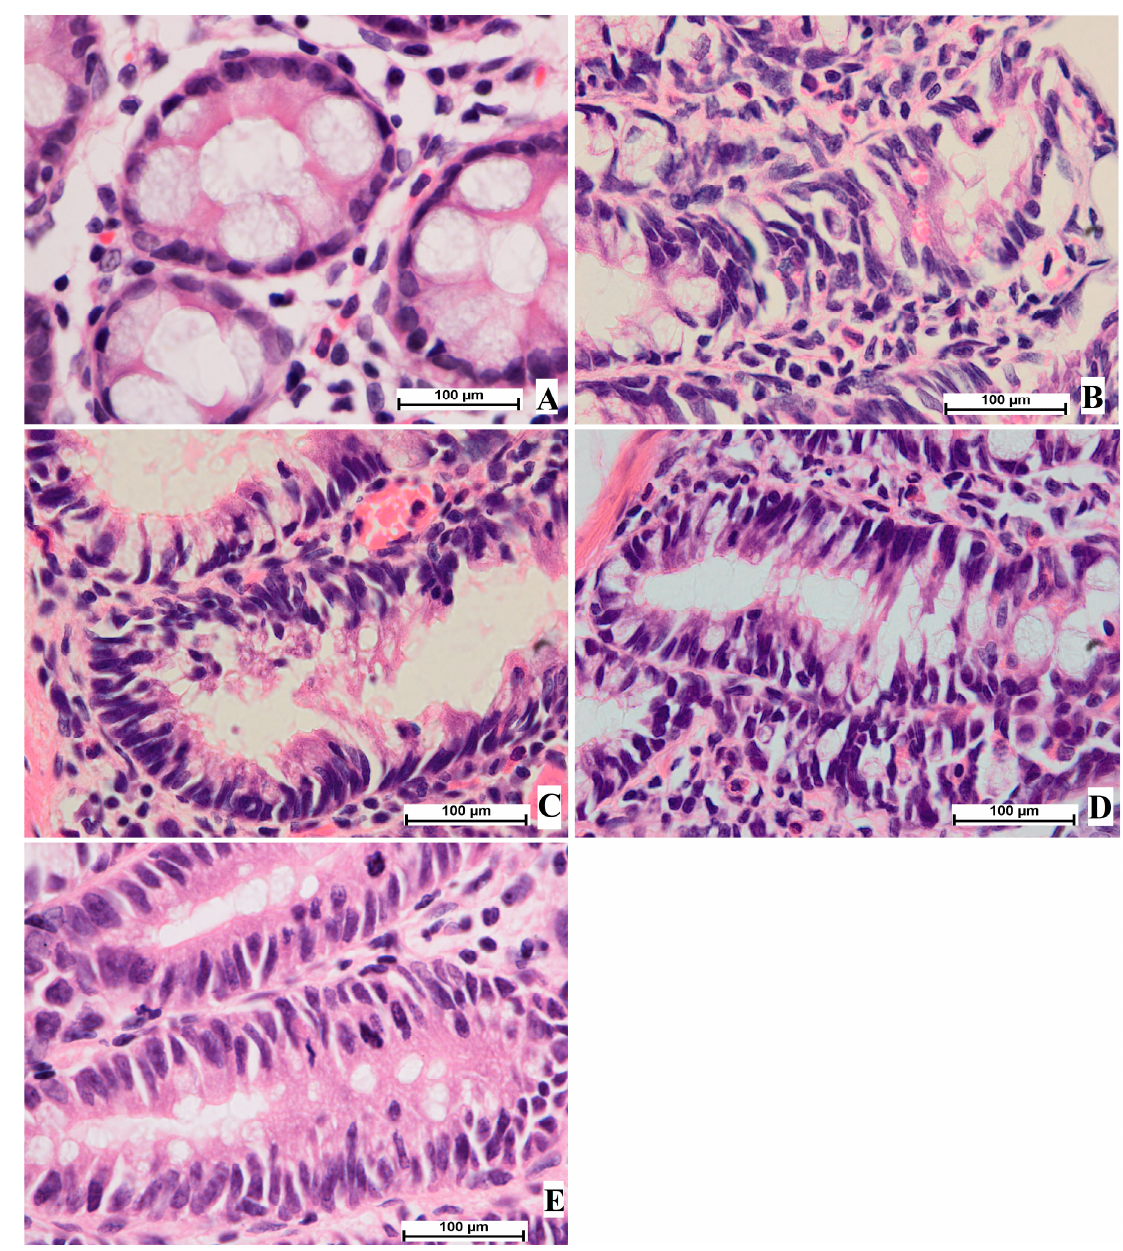
Figure 4. Histological study of colon tissue. ( A ), normal control group; ( B ), cancer control group; ( C ), reference group; ( D ), rats supplemented with 200 mg/kg of OME; ( E ), rats treated with 400 mg/kg of OME (H & E stain; 100× magnification).